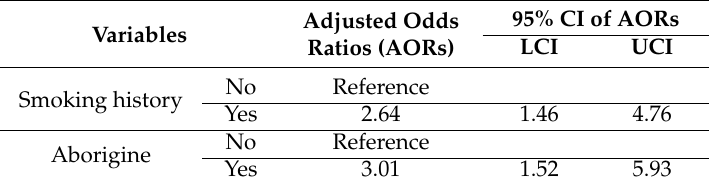
Table 2. The significant risk factors for COPD.